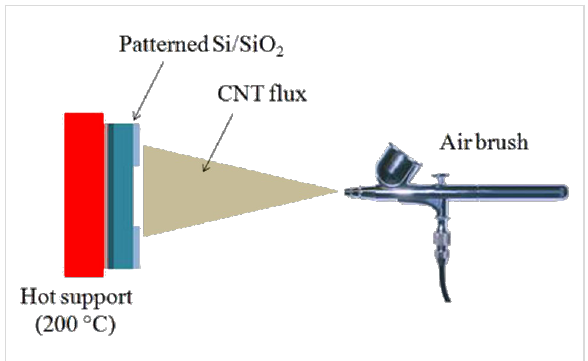
Figure 11: Schematic depiction of the airbrush deposition process. A solution of MWCNTs in isopropyl alcohol was airbrushed onto a Si/ SiO 2 sample. The SiO 2 steps avoid the formation of a short circuit between the top electrodes and the Si. The Si window was 5 × 5 mm 2 . During airbrushing, the device was mounted on a heatable holder (~200 °C) in order to allow an instantaneous evaporation of the solvent, thus avoiding the formation of